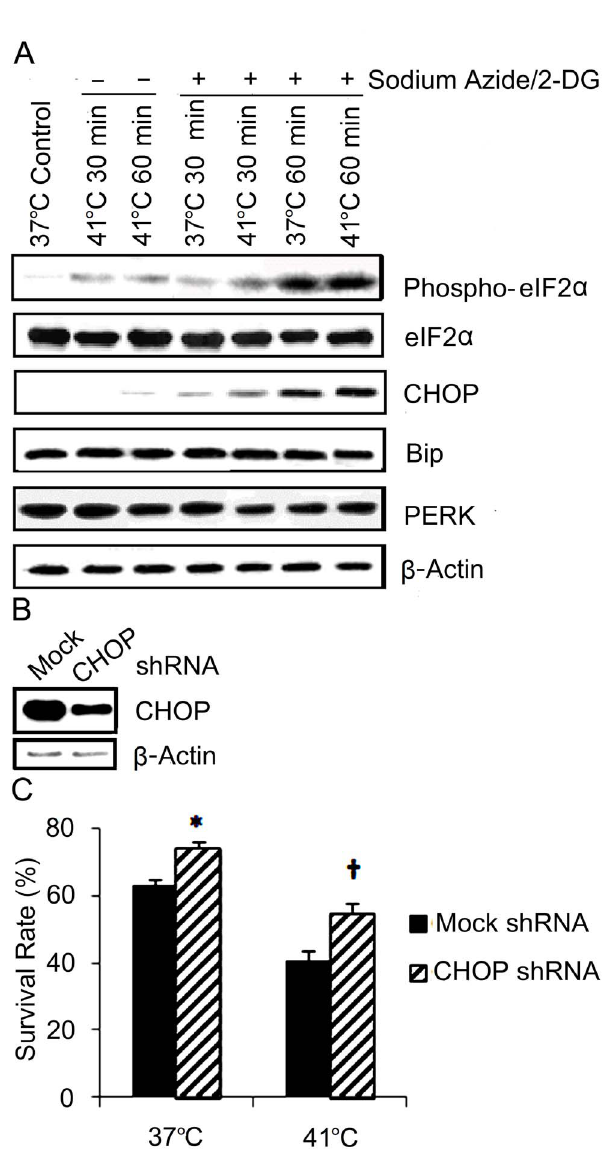
Figure 5. Temperature increase worsened sodium azide/2-DG induced ER stress. (A) Cells were subjected to treatments with sodium azide/2-DG, increased temperature or combination of sodium azide/2-DG plus increased temperature for a period of 30 minute or 1 hour. Control cells received no treatment. The cells were then collected and protein expressions were analyzed with western blot. b -actin was used as a loading control. (B) CHOP shRNA transfection significantly inhibited CHOP expression. SH-SY5Y cells were transfected with lentiviral particles encoding copGFP (mock) or CHOP shRNA. CHOP protein levels were analyzed by western blot. b -actin was used as a loading control. (C) CHOP shRNA transfection significantly reduced sodium azide/2-DG-induced cell death. Mock or CHOP shRNA transfected SH-SY5Y cells were treated with sodium azide/2-DG for 1 hour at 37 u C and 41 u C. Cell death was detected with trypan blue exclusion assay. * (p , 0.05) and { (p , 0.01) denote significant difference from the group received mock